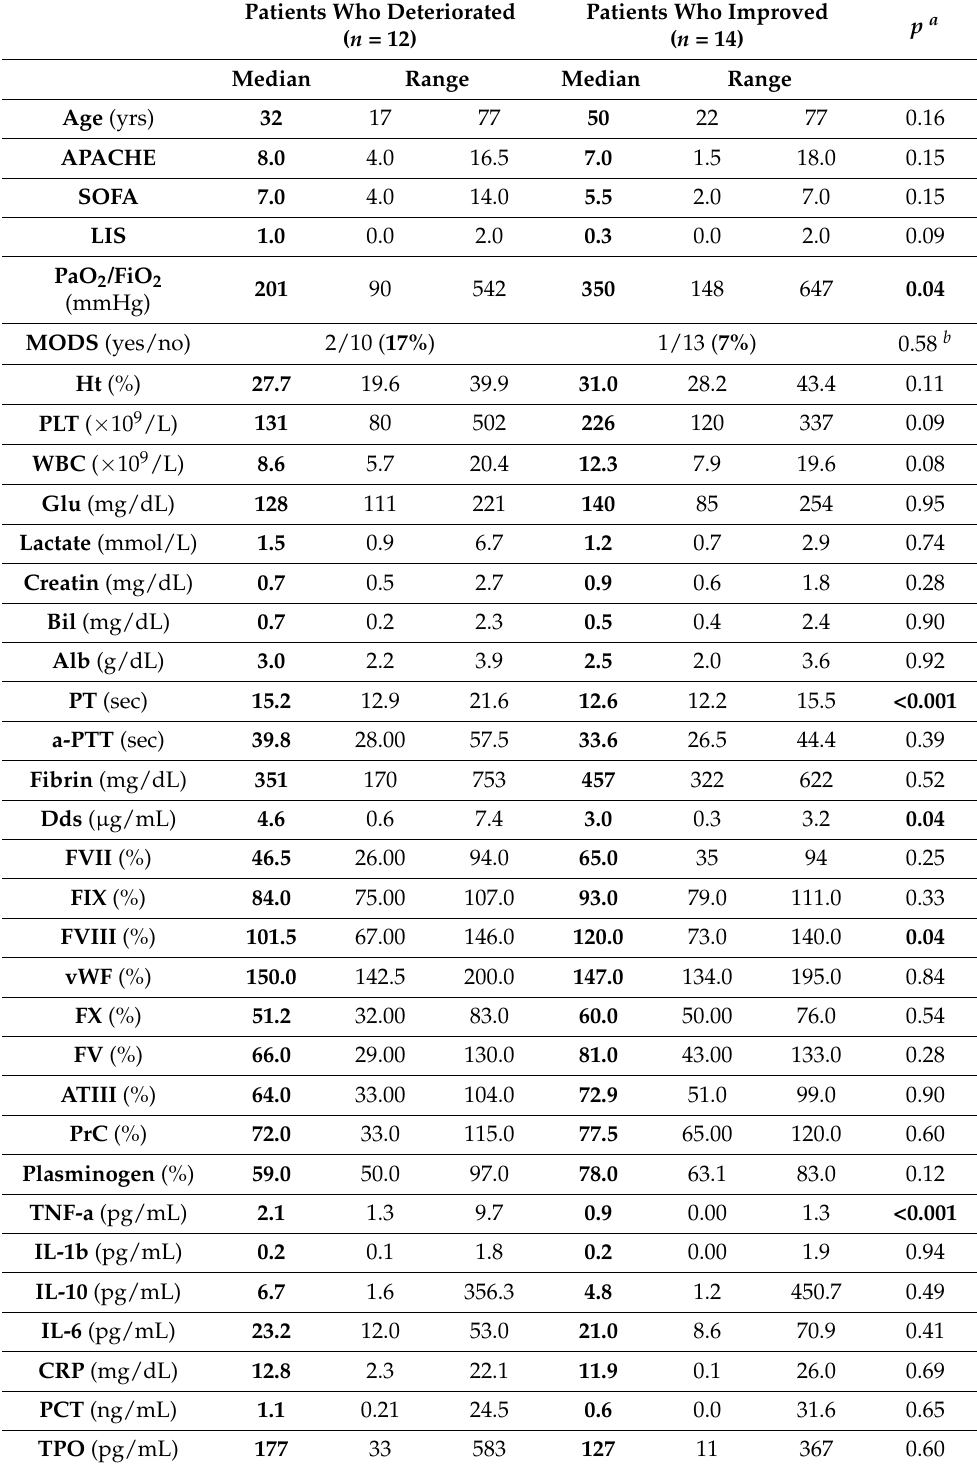
Table 3. Diagnosis of trauma or surgery without suspected infection on ICU